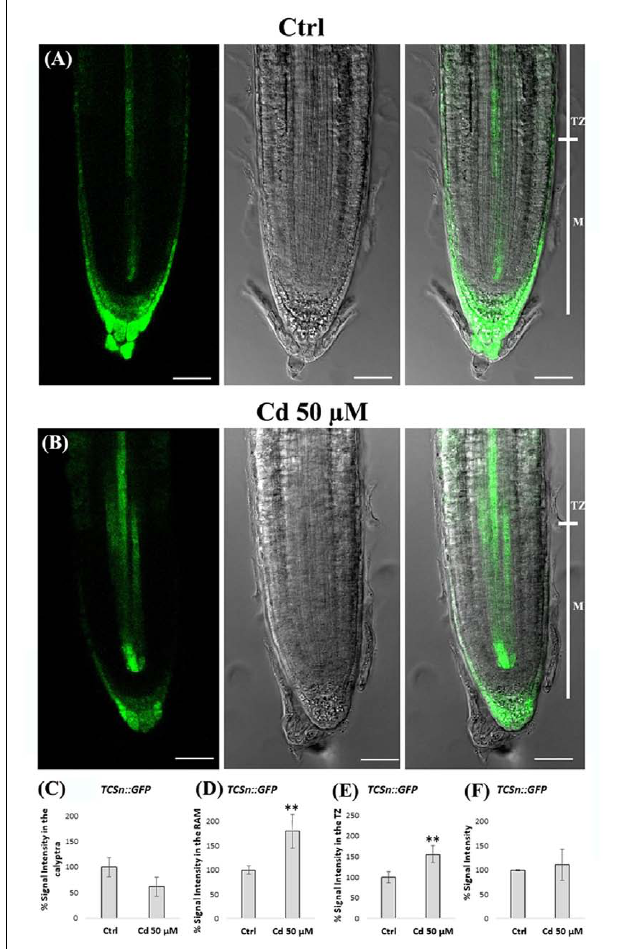
FIGURE 10 | Expression of TCSn cytokinin synthetic sensor in the primary root apex of seedlings of A. thaliana TCSn::GFP transgenic line germinated (A) on growth medium as control (Ctrl) and (B) on medium added with 50 µ M Cd for 8 days after germination (DAG). From left to right: confocal laser image; transmission image; merged image. Scale bars 46 µ m. TCSn::GFP relative signal intensities (normalized to Ctlr), in (C) the calyptra, (D) the RAM, and (E) the TZ, and (F) the whole root apex of above mentioned Ctrl and Cd-treataed roots. The results represent the mean value ( ± standard deviation) of three independent biological replicates. Asterisks indicate significant pairwise differences using Student’s t -test ( ∗ P < 0.05; ∗∗ P < 0.01; ∗∗∗ P <